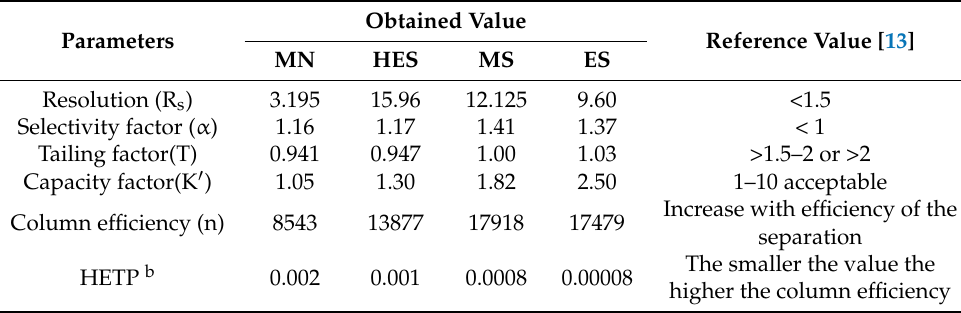
Table 3. System suitability testing parameters of the proposed HPLC method. Parameters